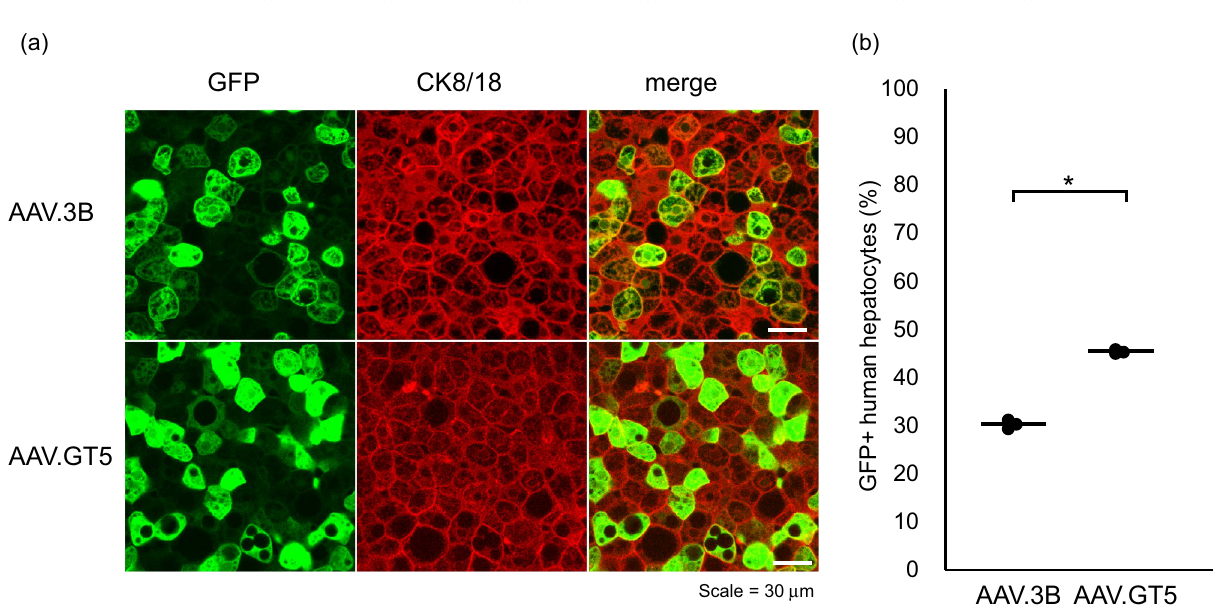
Figure 4. ( a ) Visualization of AAV vectors transduction of human hepatocytes in a chimeric mouse liver. Representative images of hepatocytes in PXB mice that received 1.0 × 10 11 vg/mouse of AAV3B or AAV.GT5 expressing GFP. Green stain, GFP; red stain, human hepatocytes (CK8/18 +). Scale bar represents 30 μm. ( b ) Comparison of transduction efficacies of AAV3B and AAV.GT5 by quantifying the percent GFP + human hepatocytes in liver sections. The black circles represent the efficiency for each mouse, and the bars represent the average. *P =